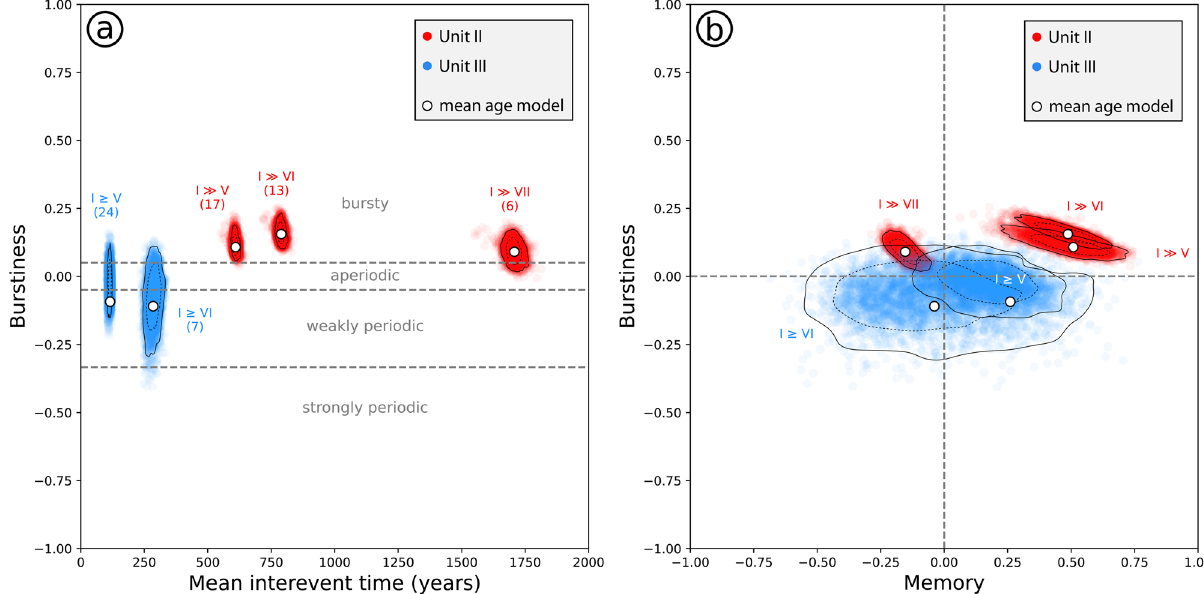
Figure 6. ( a ) Mean interevent time vs. burstiness diagram and ( b ) memory coefficient vs. burstiness diagram of different subsets of the turbidite paleoseismic record from Wörthersee. Individual datapoints result from different age-depth model iterations (> 3500 in total). Solid lines indicate 95% confidence intervals, dashed lines 68% confidence intervals. Numbers in brackets indicate the number of interevent times. In unit II, event numbers and/or intensity are underestimated due to the higher EQRT compared to unit III.